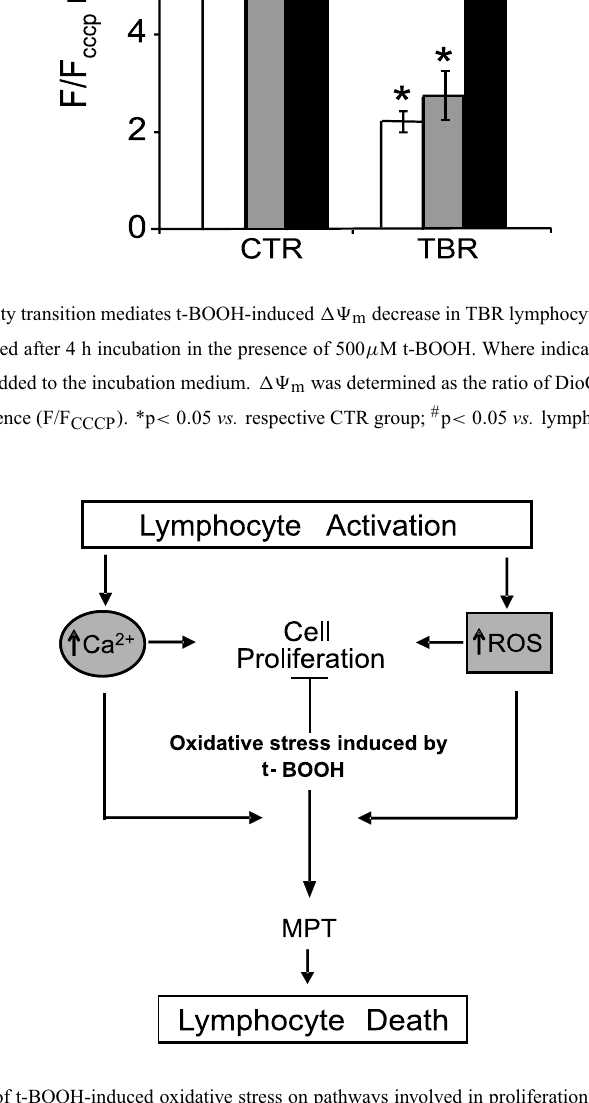
Fig. 8 – Summary of the effects of t-BOOH-induced oxidative stress on pathways involved in proliferation and death of activated lymphocytes. The process of lymphocyte activation involves both ROS overproduction and increases in [Ca 2 + ] cyt . Treatment with agents that induces cellular oxidative stress (e.g. t-BOOH) leads to a conversion of the physiological signals from proliferation to death of activated lymphocytes. t-BOOH induces oxidative stress by exhausting cellular antioxidants and promoting free radicals generation. t-BOOH results in necrotic death mediated by mitochondrial permeability transition (MPT)